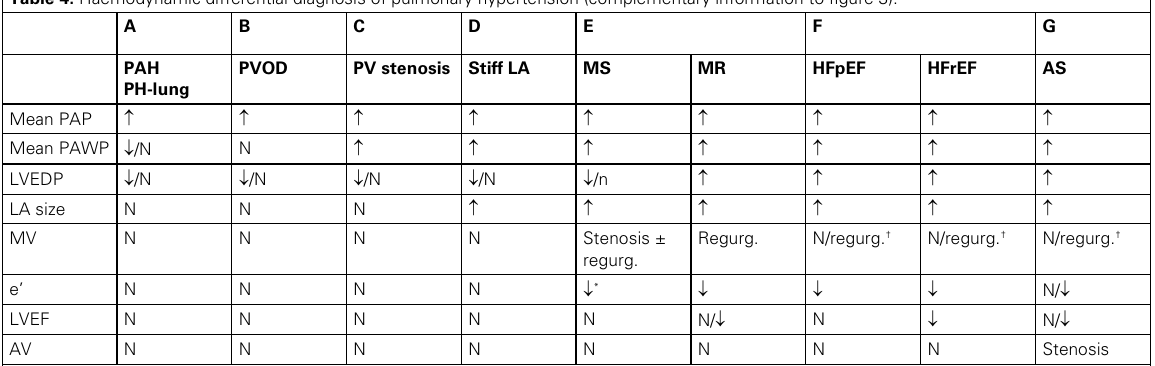
Table 4: Haemodynamic differential diagnosis of pulmonary hypertension (complementary information to figure